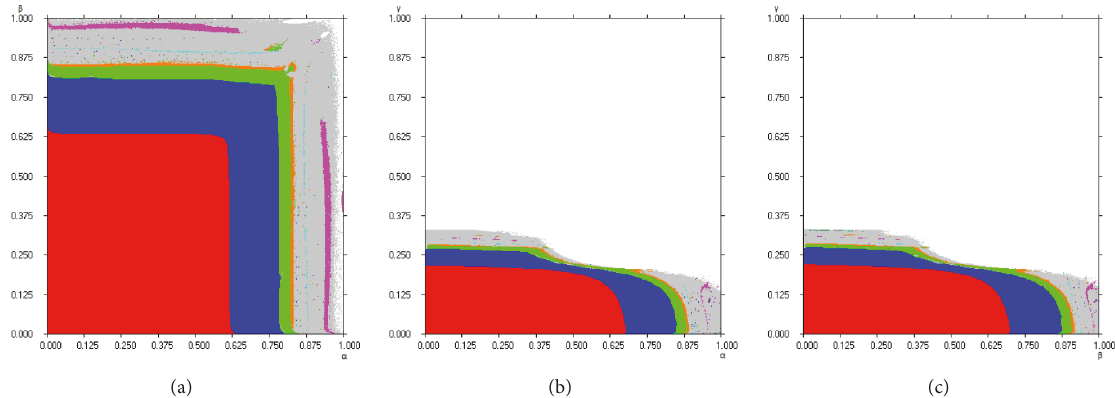
Figure 2: (a) The stability with 𝛼 and 𝛽 is changed and 𝛾 = 0.15 . (b) The stability with 𝛼 and 𝛾 is changed and 𝛽 = 0.25 . (c) The stability with 𝛽 and 𝛾 is changed and 𝛼 = 0.16 .